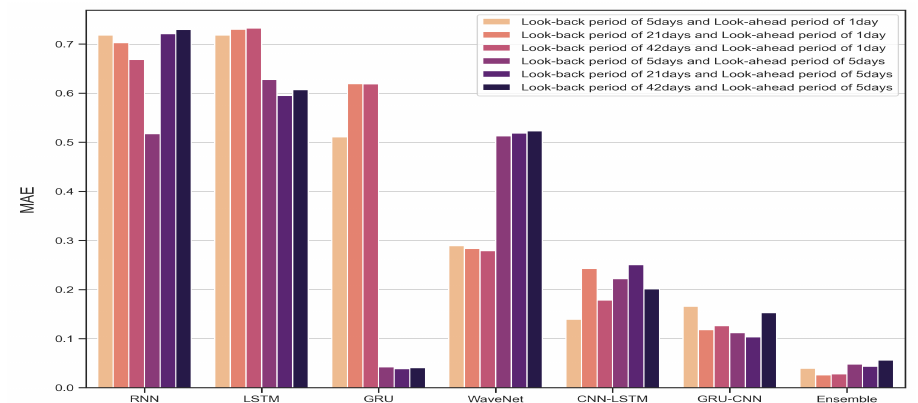
Figure 16. Comparison of the average MAE over three periods for different look-back and look-ahead periods using RNN, LSTM, GRU, WaveNet, CNN-LSTM, GRU-CNN, and ensemble with OHLV features.